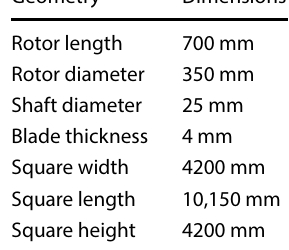
Table 1 Geometric specifications of wind